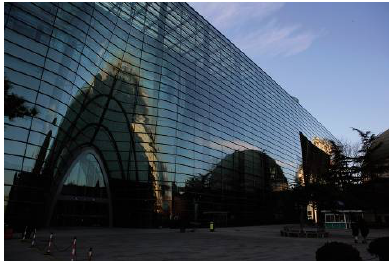
Figure 4: Beijing Planetarium. Figure 5: Forbidden City Meridian Gate